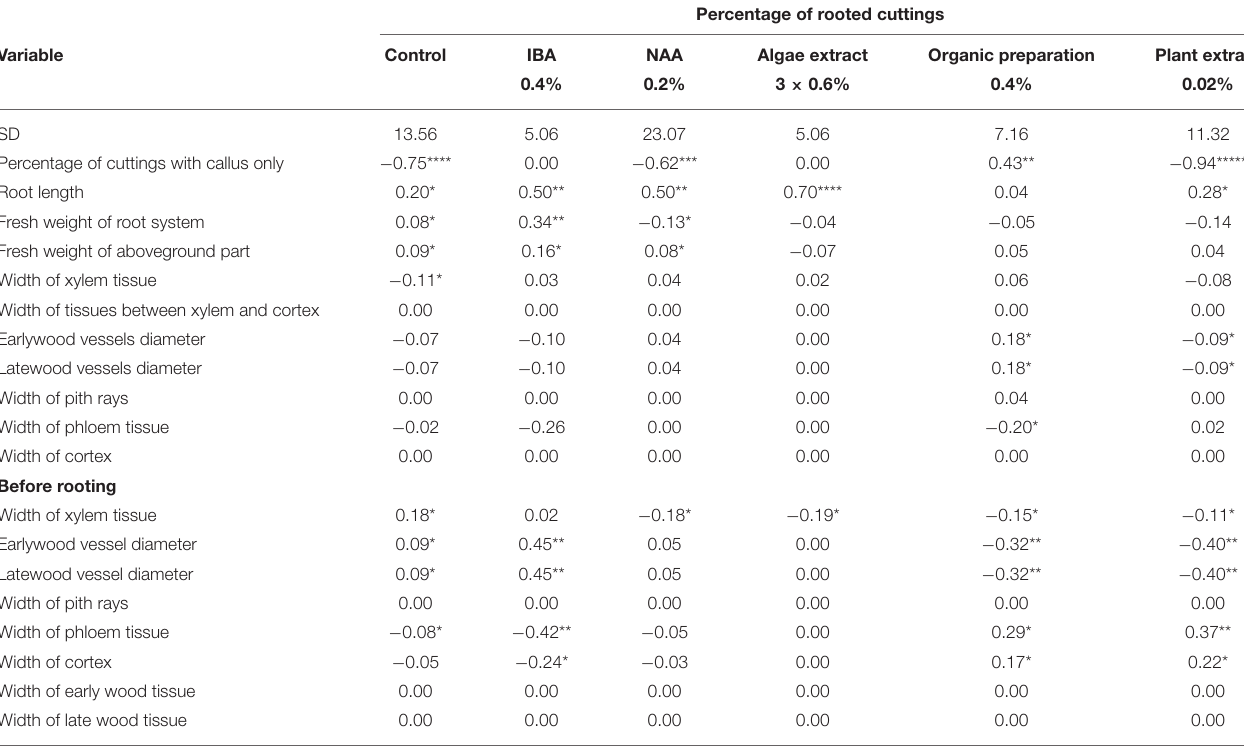
TABLE 4 | Effect correlations between percentage of rooted cuttings and measured parameters of growth and anatomical structure in Rosa “Hurdal” before and after 25 days of rooting cuttings derived from shoots H2, in full flowering; at least 50% of flowers open (BBCH 69